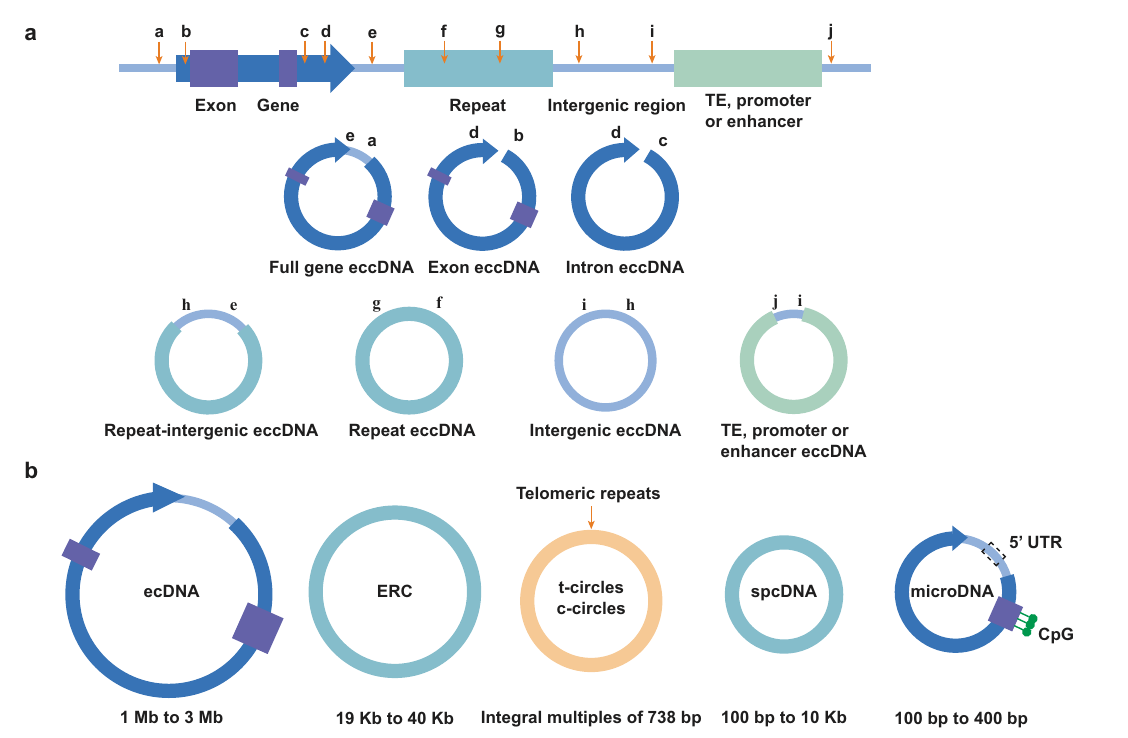
Fig. 3 Structures and biological features of eccDNA. a Based on genomic origin and genetic content, eccDNAs are categorized into the following types: full-gene eccDNA, exon eccDNA, intron eccDNA, repeat eccDNA, repeat-intergenic eccDNA, intergenic eccDNA, TE, promoter or enhancer eccDNA. b Based on size and sequence, eccDNAs are categorized into the following types: small polydispersed DNA (spcDNA), microDNA, telomeric circle (t-circle/c-circle), extrachromosomal rDNA circle (ERC), and extrachromosomal DNA (ecDNA). The main elements and structures of eccDNAs are